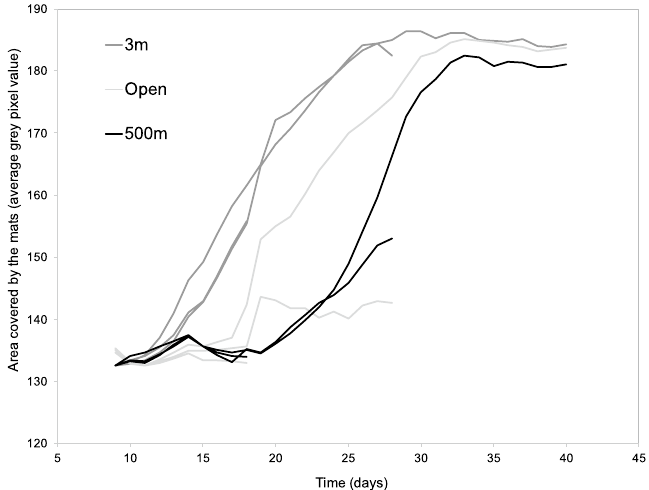
Figure 1. a. Continuous measure of the area covered by the microbial mats growing on the logs in aquaria inoculated with sea water from 3 and 500 m depth, and open circulation. The lines stop when the wood logs were sampled for bacterial community analysis after 19 days, 28 days and 40 days.